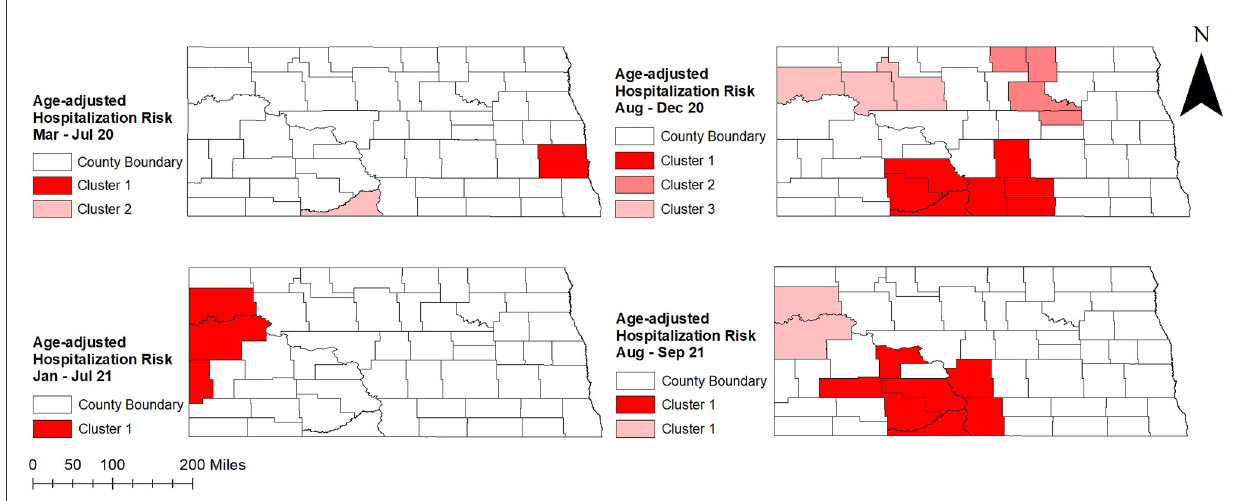
FIGURE5 Spatial clusters of age-adjusted high COVID-19 hospitalization risks identified in North Dakota using Tango’s flexible spatial scan statistics, March 2020–September 2021.